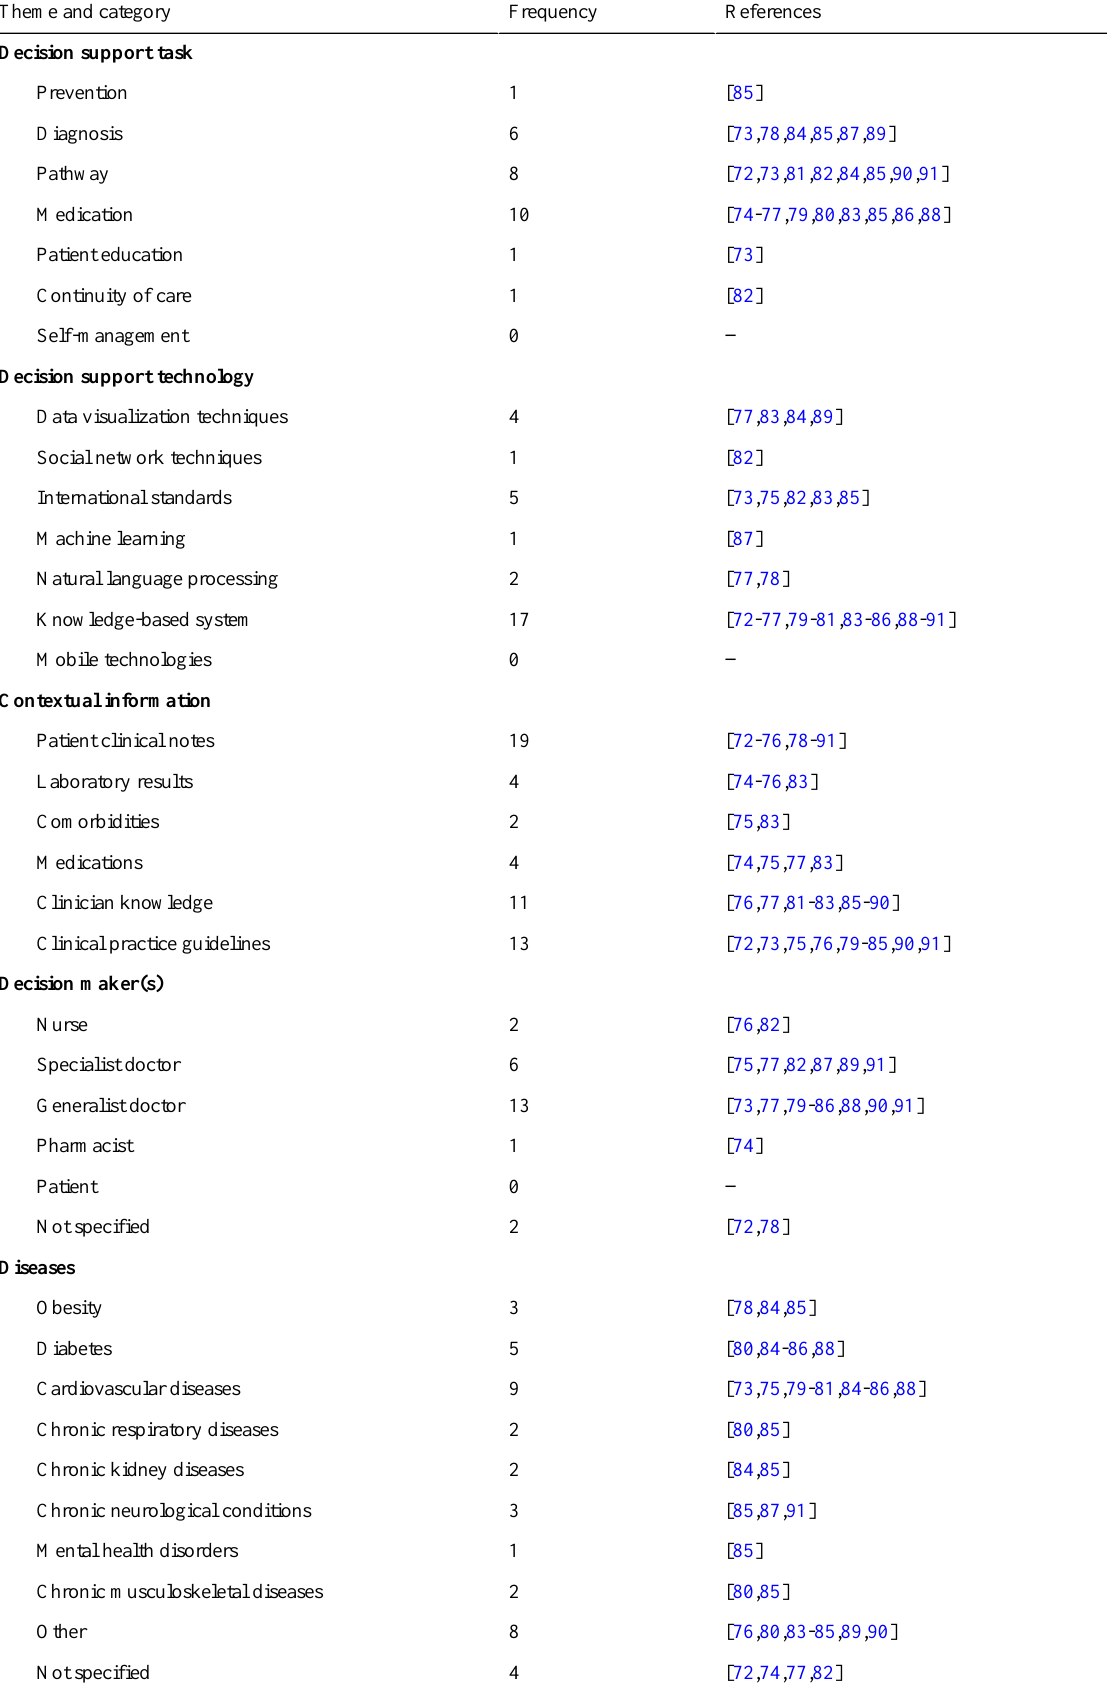
Table 2. Synthesis of occurrences’numbers and references for collected data